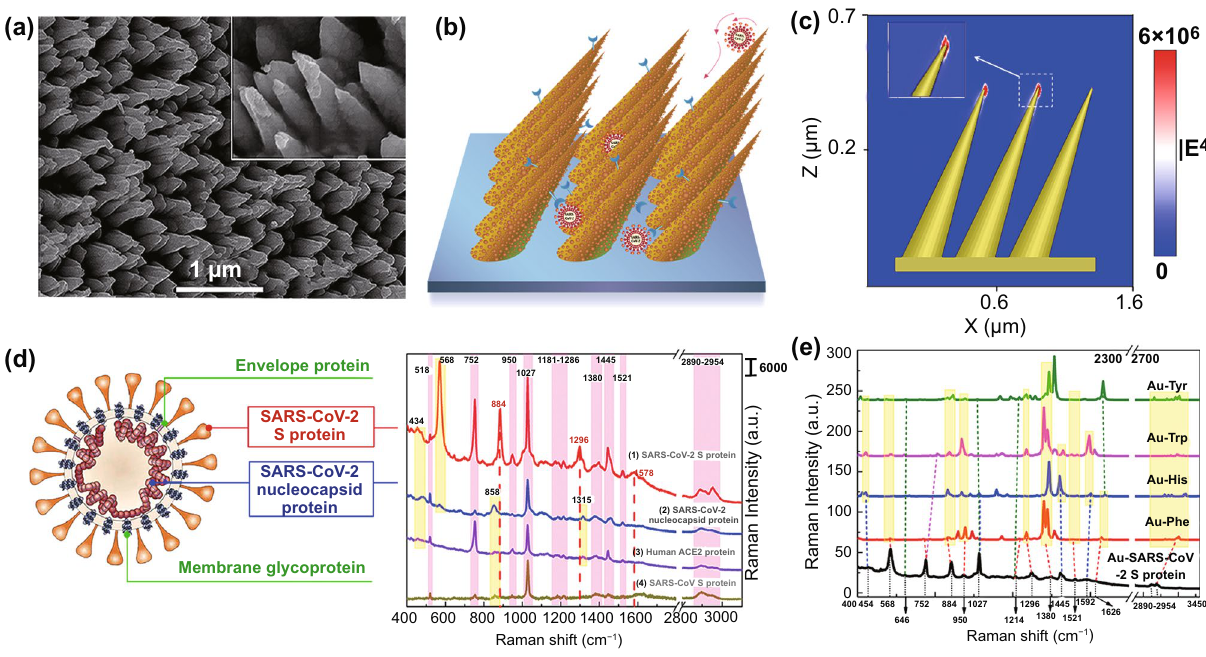
Fig. 2 Morphology analysis of gold‑nanoneedles array and SERS spectra of viral protein. a SEM images of Au nanoneedles array fabricated by Ar + ions irradiation at a tilted angle of 45° on an Au film of 500 nm in thickness. b Schematics of “virus‑traps” nanoforest composed of tilted gold‑nanoneedles array. c Calculated intensity distribution (|E| 2 ) at 785 nm for a tilted Au nanoneedle array with the polarization of the incident laser along the x‑axis. d Structure schematics of SARS‑CoV‑2 (left), and SERS spectra (right) of SARS‑CoV‑2 S protein and nucleocapsid pro‑ tein, SARS‑CoV S protein, and Human ACE2 protein at 100 nM level. e Calculated static Raman spectra of 4 types of main individual amino acids Tyr, Trp, His, Phe encoded in SARS‑CoV‑2 S on Au